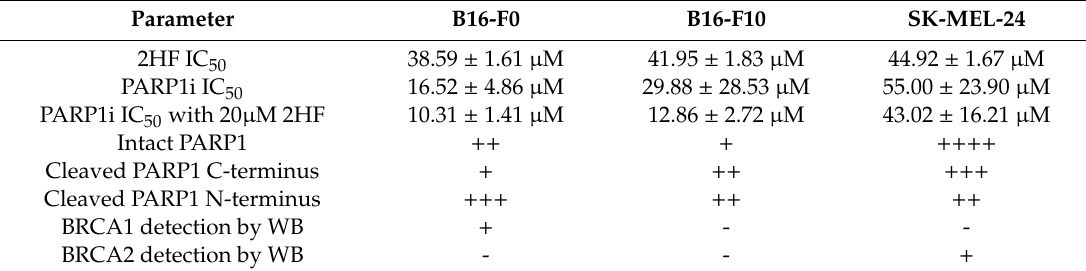
Table 1. E ff ect of 2HF on melanoma cell proliferation is independent of Breast Cancer gene (BRCA) expression